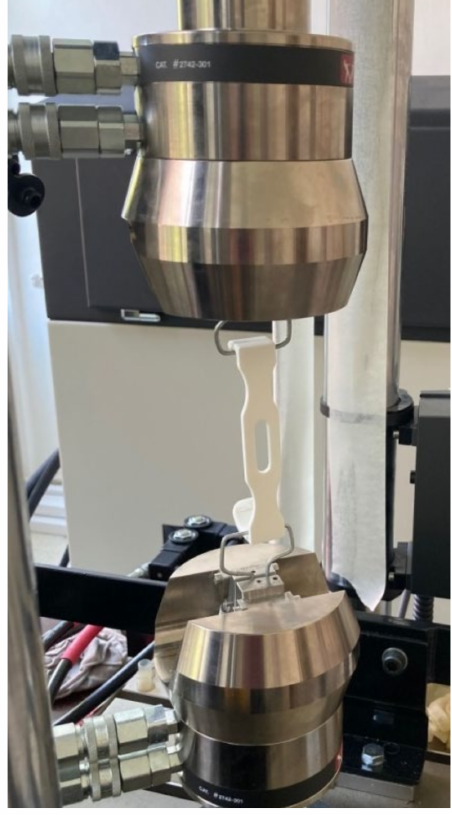
Figure 3. Experimental set-up for the testing of surgical